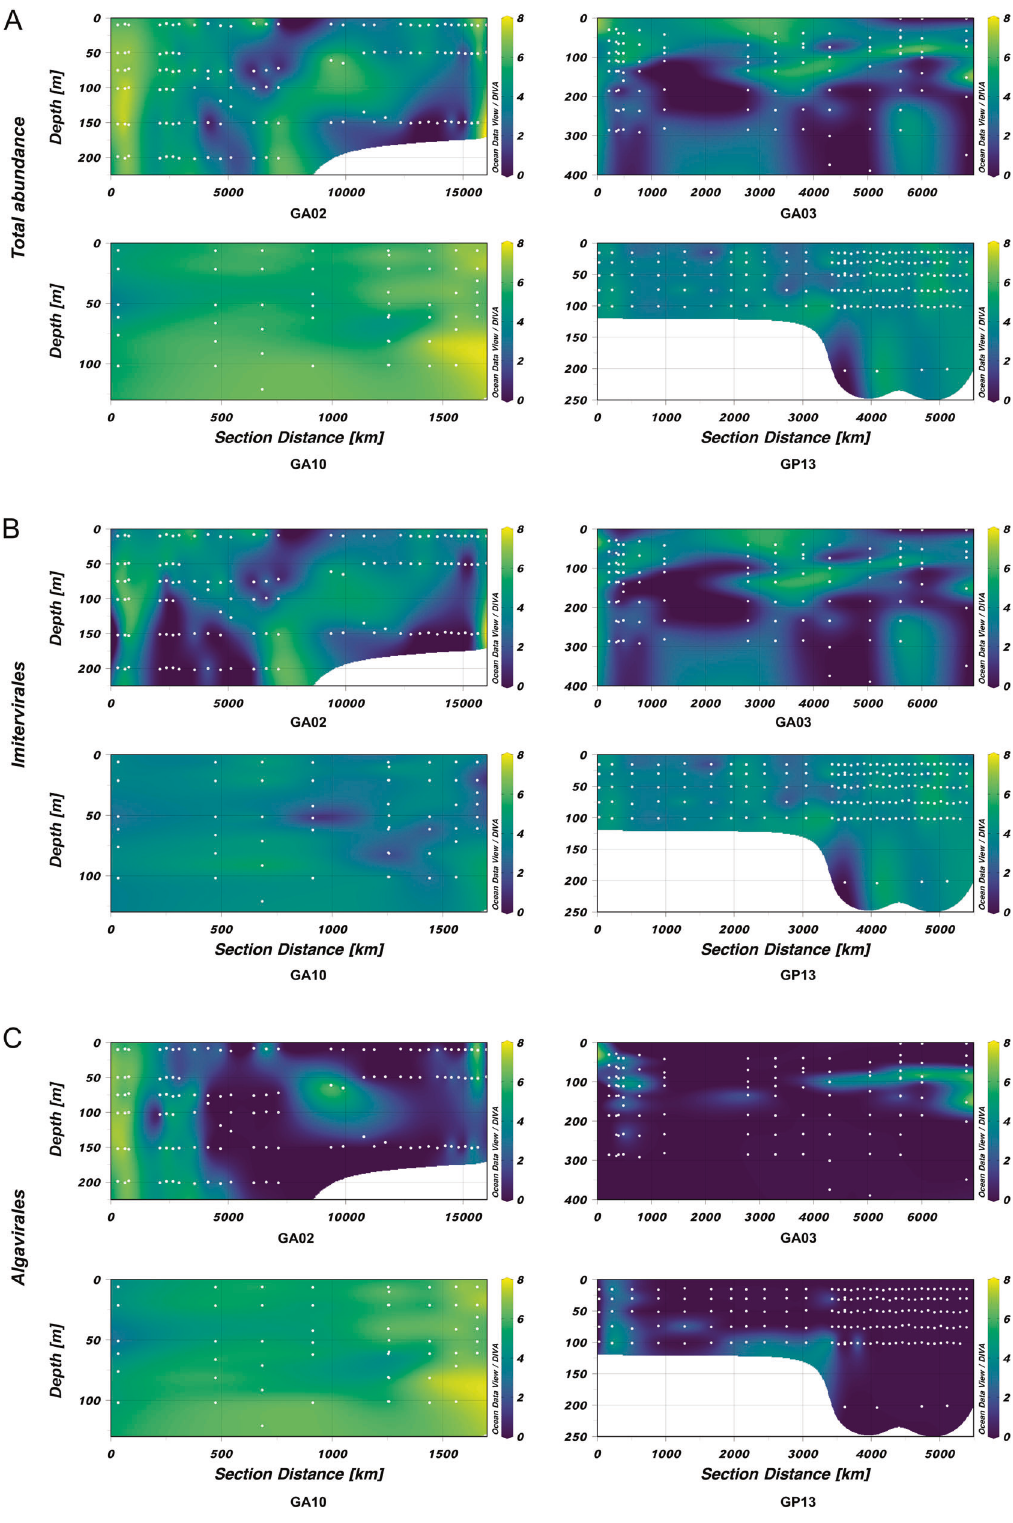
Fig. 5 Distribution of viruses throughout the water column along the transects. Graphs show the viral abundance (calculated in RPKM, natural log transformed) of ( A ) total giant viruses present in each of the transect, ( B ) viruses of the Imitervirales order, and ( C ) viruses of the Algavirales order. Samples were ordered based on the distance along transects, beginning from the fi rst sampling location of cruise tracks (0 km). White dots denote the sampling location along the transect of each